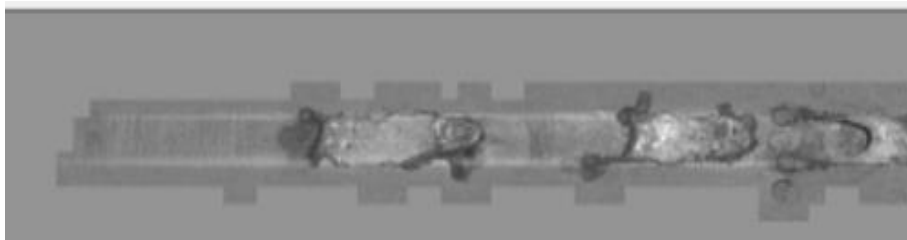
Figure 8. A visible sliver on the strip surface. Processed in Ametek [30].